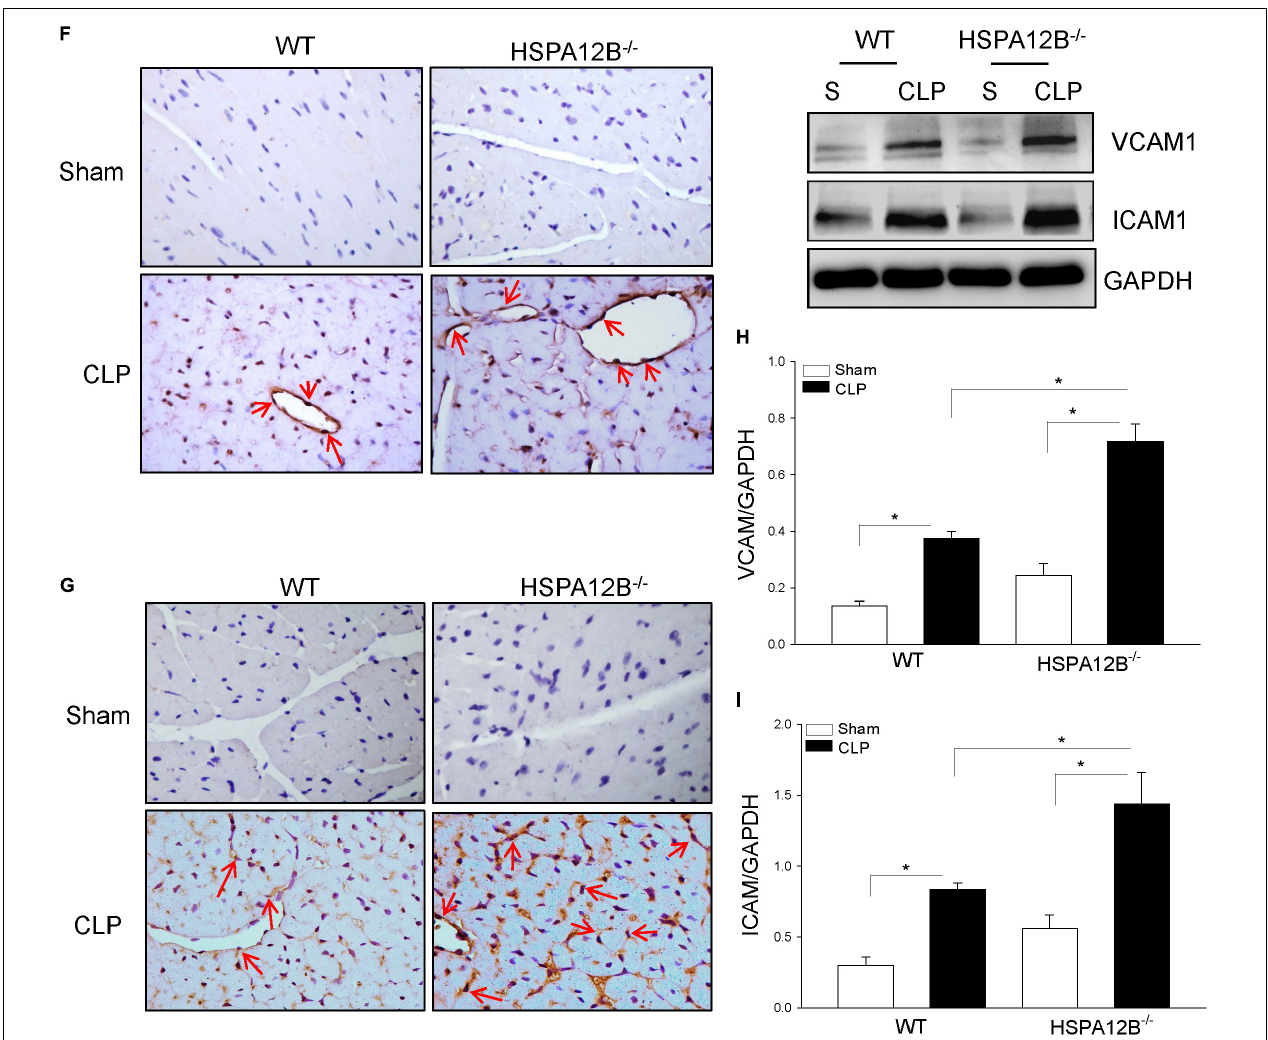
FIGURE 2 | Increased accumulation of immune cells and NF- κ B binding activity in the myocardium of HSPA12B − / − septic mice. Wild-type and HSPA12B − / − mice were subjected to CLP sepsis or sham surgical operation. Heart tissues were harvested 6 h after CLP. (A) The accumulation of neutrophils in heart tissues was examined by immunohistochemistry with antineutrophil antibody and MPO activity ( n = 6–8/group). (B) Macrophages in the heart tissues were examined by antimacrophage antibody F4/80. The positive staining of neutrophils and macrophages are dark brown color marked with red arrows. (C) Myocardial NF- κ B binding activity in WT and HSPA12B − / − septic mice was performed with EMSA ( n = 6–8/group). (D,E) Serum cytokine TNF α (D) and IL-6 (E) levels were measured by EMSA kits ( n = 4–8/group). (F–I) Increased expression of adhesion molecules in the myocardium of WT and HSPA12B − / − septic mice. Heart tissues were harvested 6 h after CLP, sectioned, and subjected to immunohistochemistry staining with anti–VCAM-1 (F) and anti–ICAM-1 (G) antibodies. (H,I) Western blot analysis of VCAM-1 (H) and ICAM1 (I) levels in the heart tissues. n = 4–8/group. * P < 0.05 compared with indicated groups. The immunohistochemistry staining was examined with bright field microscope (40 ×